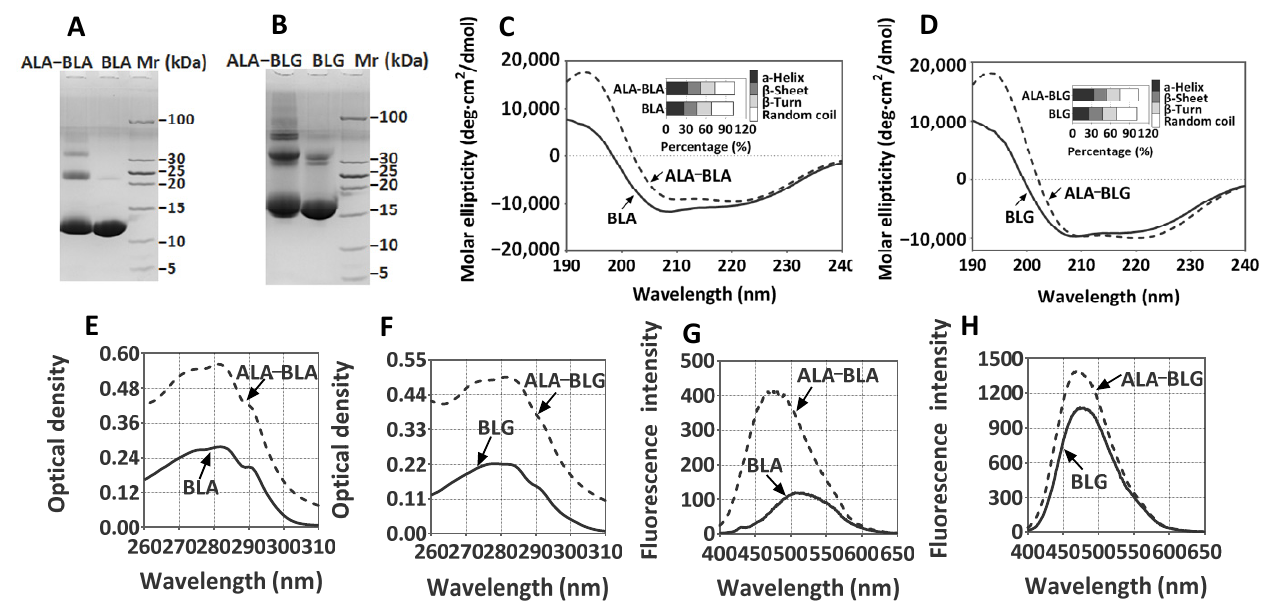
Figure 2. Characterization of ALA–BLA and ALA–BLG: ( A , B ) nonreducing tricine–SDS–PAGE